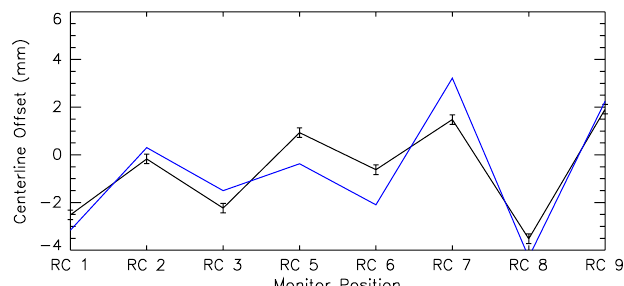
FIG. 15. (Color) Steering solution using the default values for the UMER ring; a comparison of measured (black) to predicted values (blue).